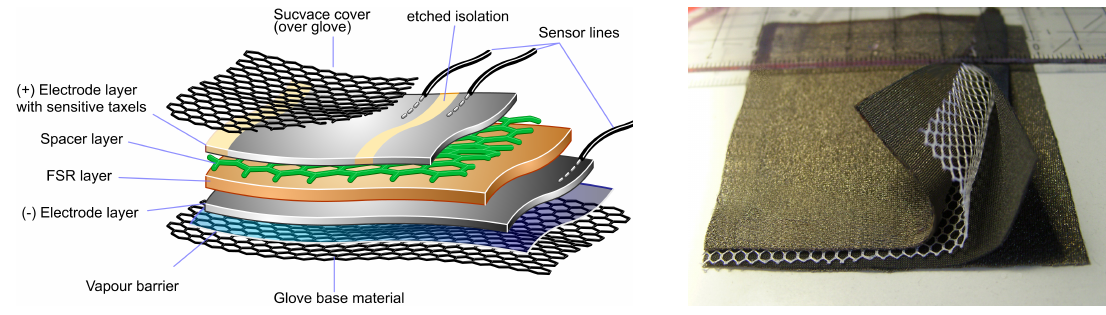
Figure 5. The flexible tactile sensing glove is manufactured from several layers of conductive and piezo-resistive